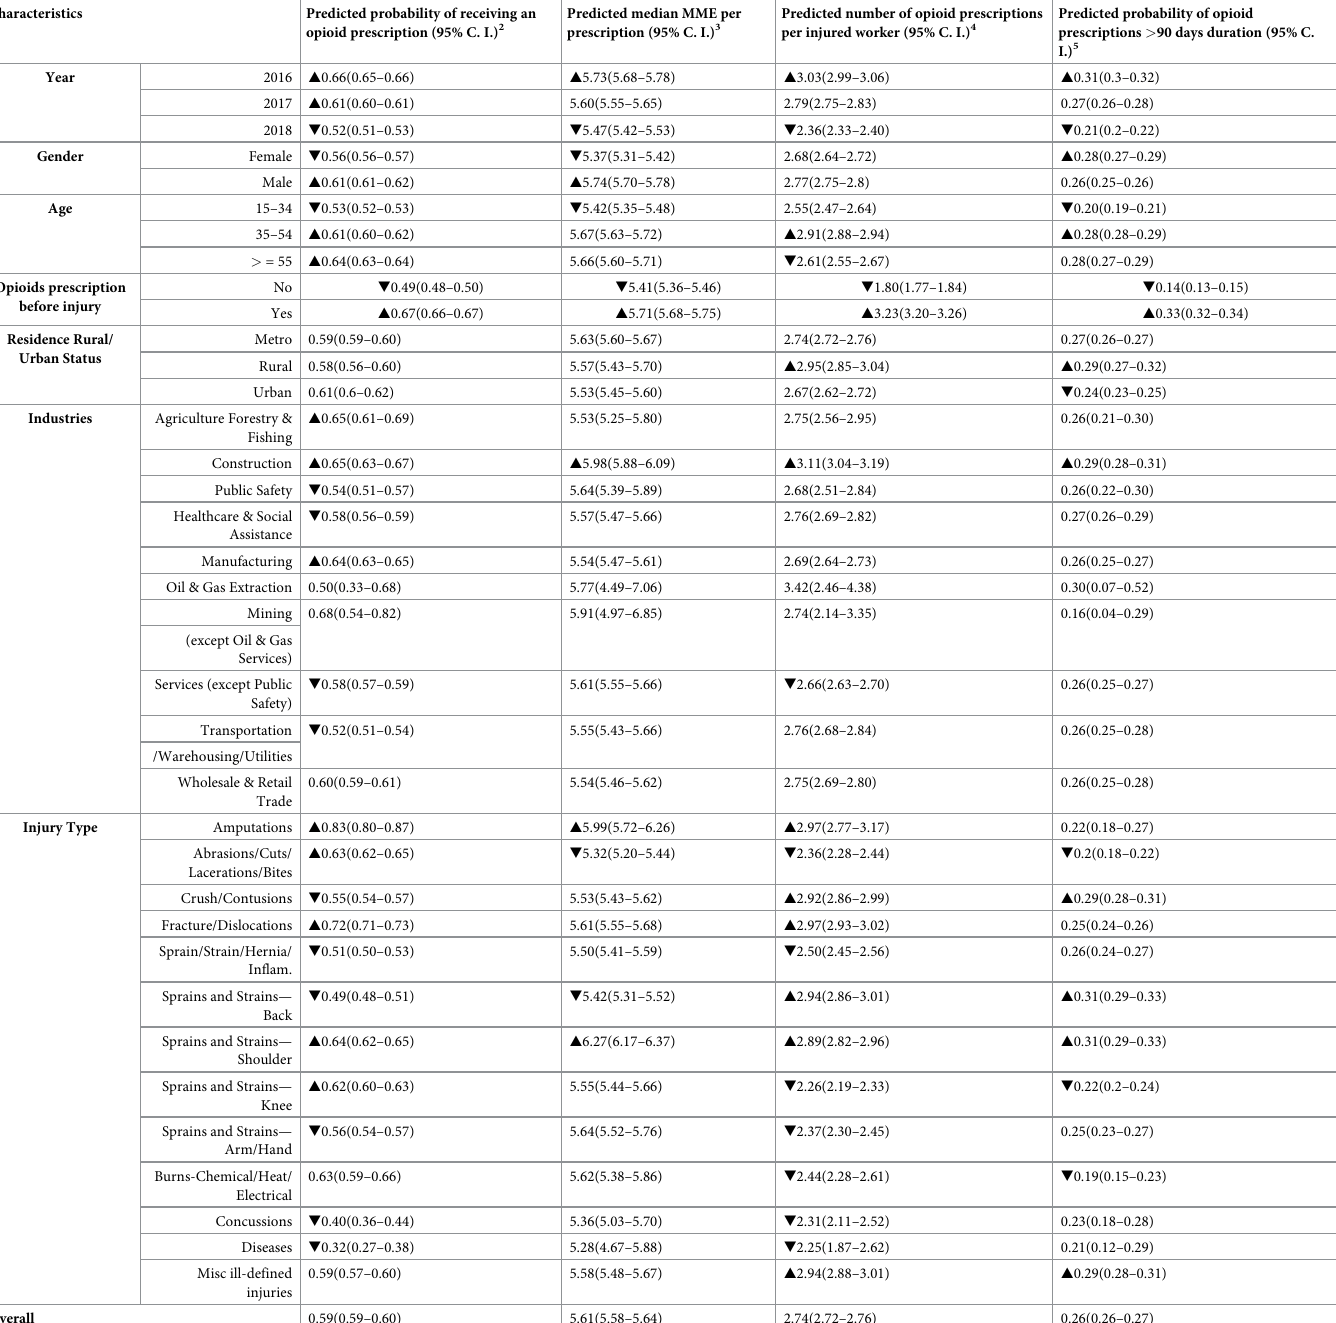
Table 4. Predicted probability of an injured worker receiving an opioid prescription, predicted median MME per prescription, predicted number of opioid pre- scriptions per injured worker and predicted probability of an opioid prescriptions > 90 days duration within 6 months of a work-related injury based on multivari- ate